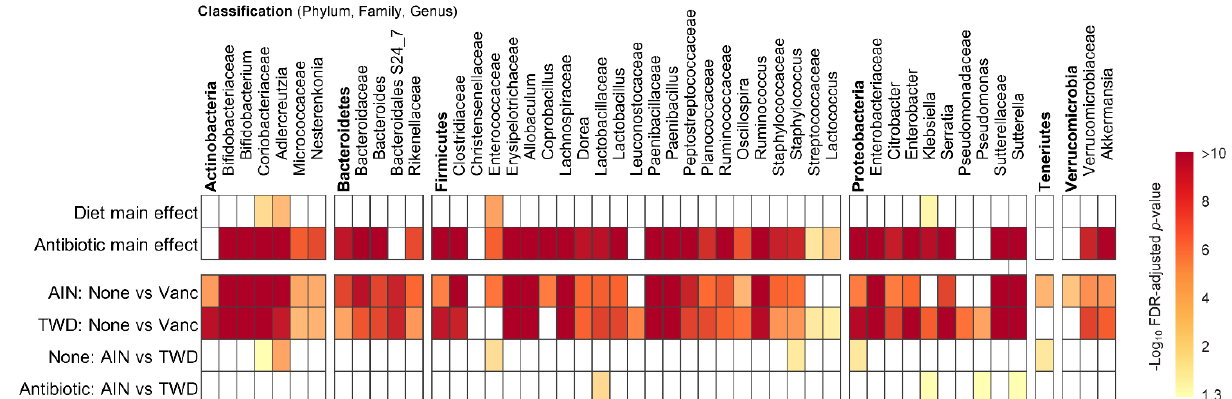
the AIN93G diet; TWD, the total Western diet; Vanc, vancomycin.